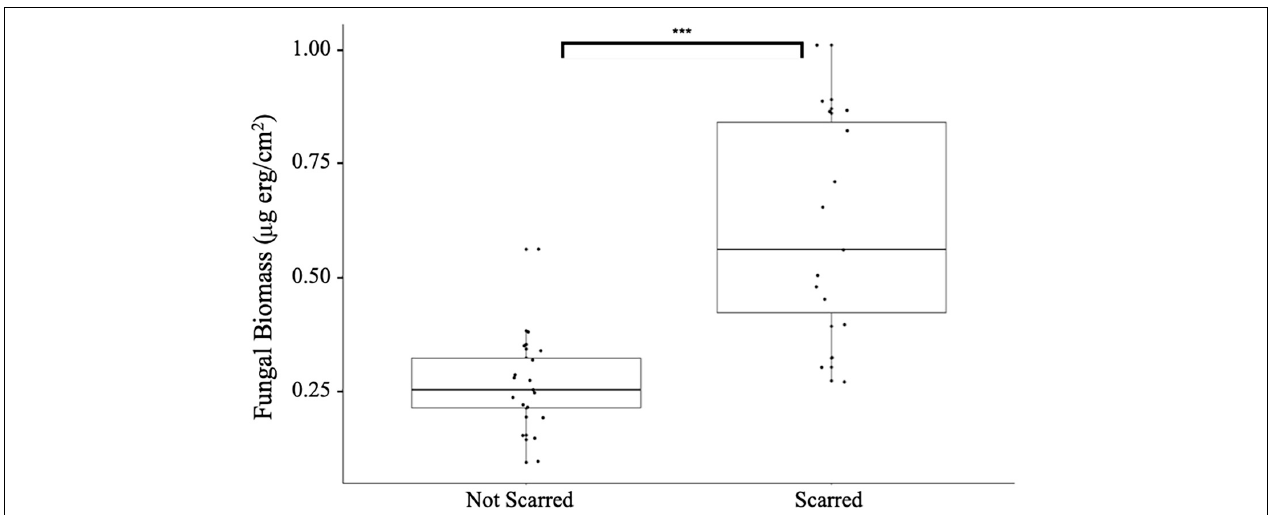
FIGURE 5 | Fungal biomass ( µ g erg/cm 2 ) on turtlegrass blades that were not manually scared compared to turtlegrass blades that were manually scared. Significant p -values comparing groups were calculated through a one-way ANOVA and a Tukey test, *** p ≤ 0.0001.